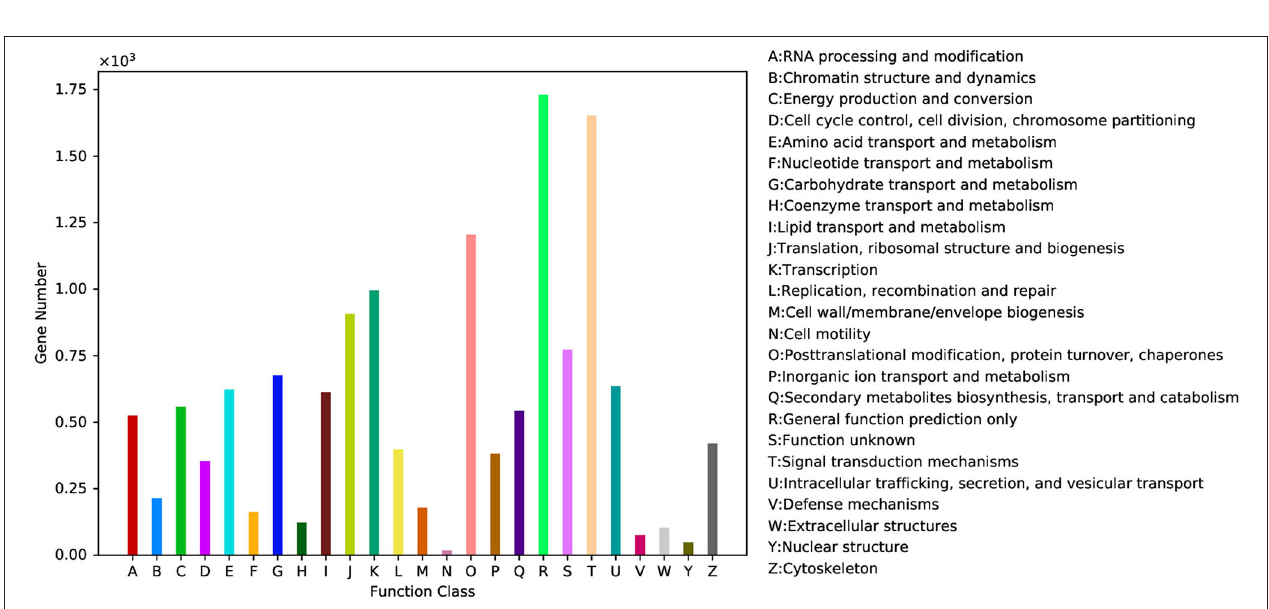
FIGURE 4 | Gene Ontology (GO) categories of the unigenes. Distribution of the GO categories assigned to the M. aurolineatus transcriptome. Unique transcripts (unigenes) were annotated in three categories: cellular components, molecular functions, and biological process.